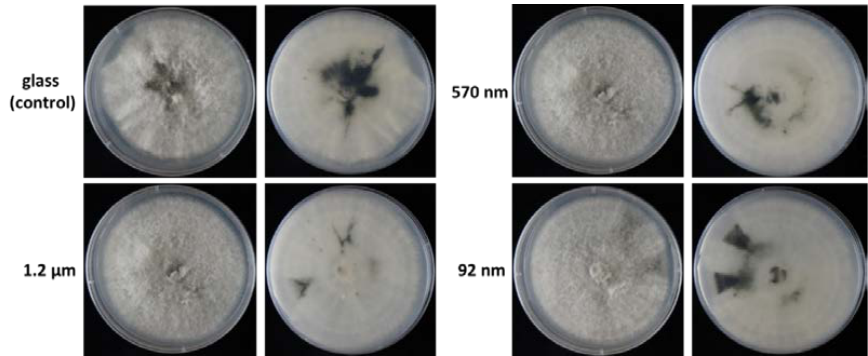
Figure 7. Morphologies of C. gloeosporioides following treatment with different Ag samples. Appl. Sci. 2020 , 10 , x FOR PEER REVIEW